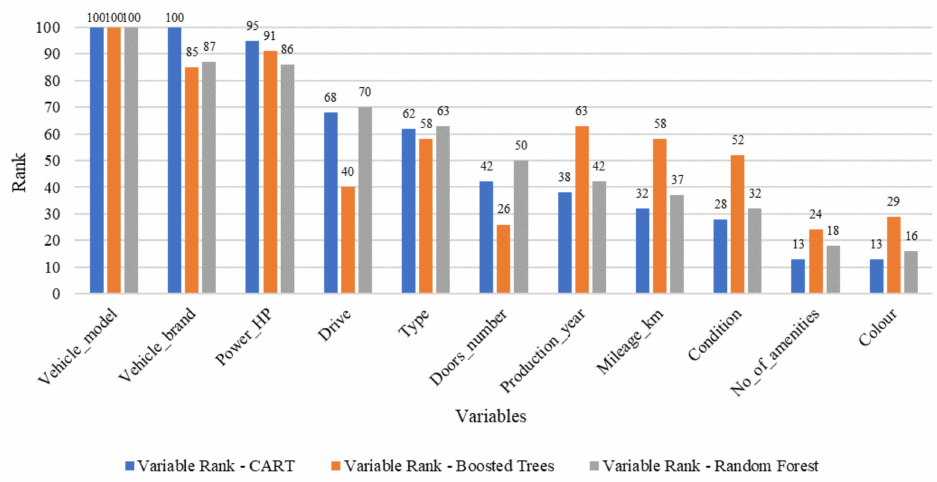
Figure 4. Predictor importance ranking based on the CART algorithm, random forest, and boosted trees.